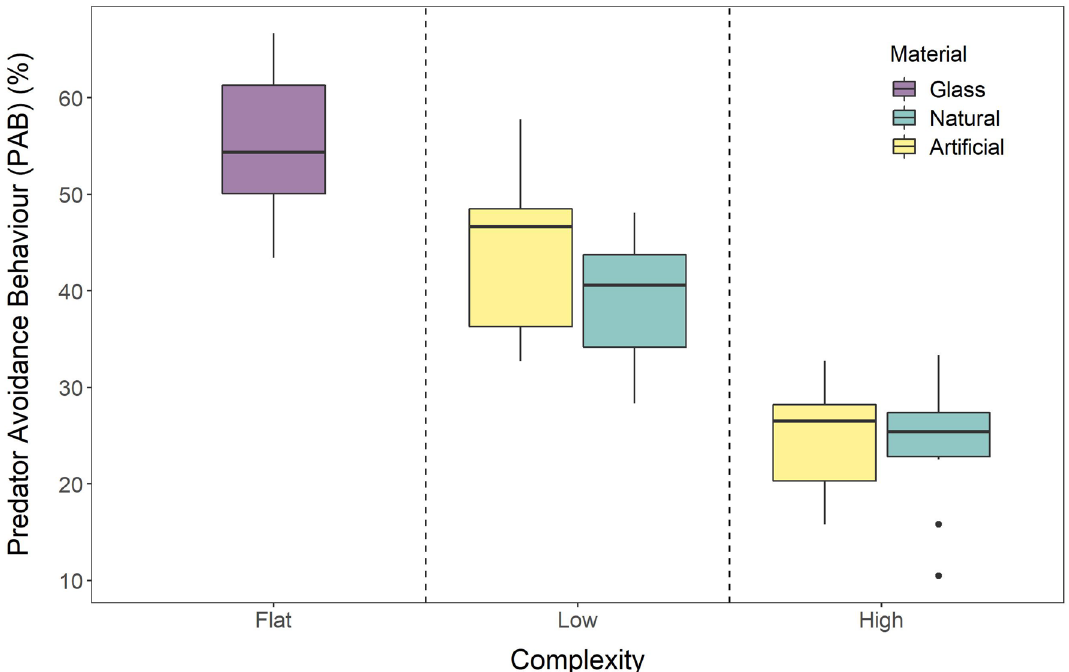
Figure 5. Impacts of habitat complexity on the predator avoidance behaviour (PAB) of D. antillarum . Flat treatments were carried out in trial tanks without any structure, low complexity treatments with natural material occurred in tanks enriched with fragments of reef rubble, and low complexity treatments with artificial materials were conducted in tanks with fragmented breezeblocks. High complexity treatments with natural material used reef rubble to simulate a reef crevice, and during high complexity treatments with artificial material individuals were provided with a whole breezeblock. The study was fully factorial and n = 10 for each treatment. The bold horizontal line on each boxplot represents the mean, the box itself shows the interquartile range and the whiskers delimit the full range of the data. Letters above the plots show the result of a post hoc Tukey–Kramer analysis and show where significant differences between treatments